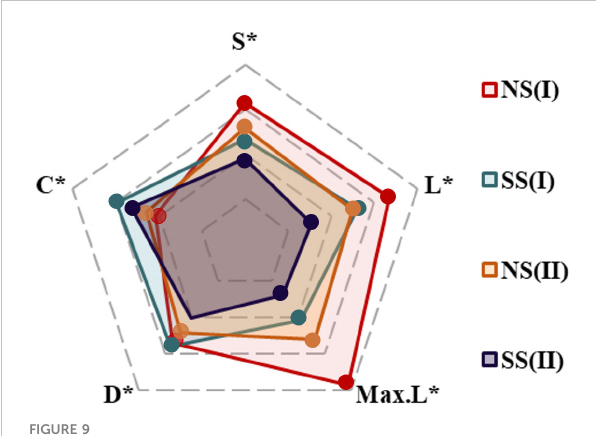
FIGURE 9 Five topological indexes of food webs in different regions/periods: (I) Flood season; (II)Non- fl ood season; (NS)Northern shore; (SS) Southern shore (S*, L*, Max.L*, D* and C* represented the vector normalization value of S, L, Max.L, D and C,